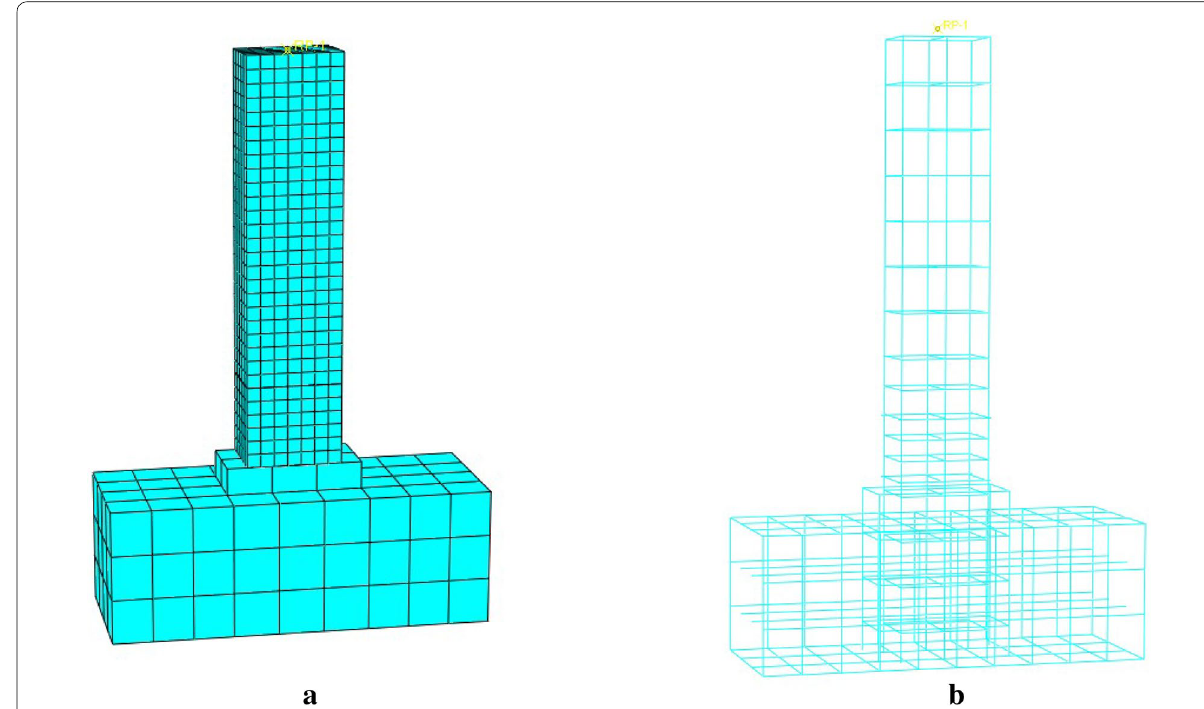
Fig. 12 FE modeling of the precast concrete column with improved URF connection (ZP6): a meshed concrete; b the